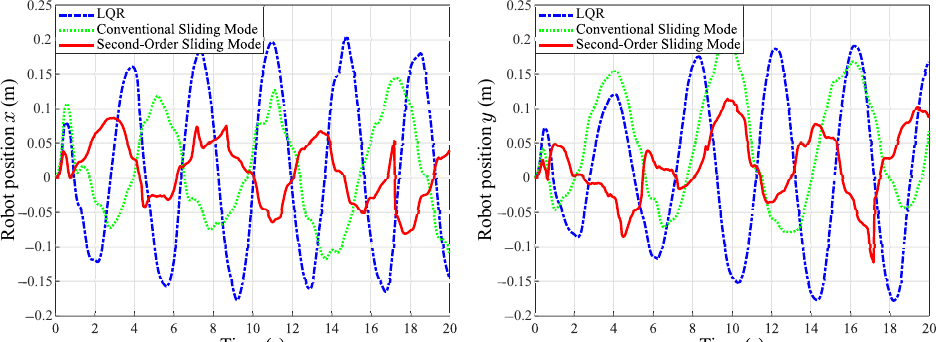
Figure 21. The experimental results of the spherical inverted pendulum compare the robot’s position responses on the X -axis and Y -axis, respectively.